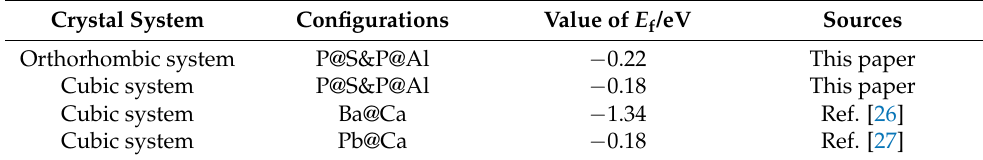
Figure A3. Calculation results of PDOS for pure and the most probably P-doped ye’elimite (position of the Fermi energy level (0 eV) is indicated by a dotted line), ( a ) P@S ＆ P@Al(ST) and ( b ) P@S ＆ P@Al(SS). Table A5. Comparison of E f in this paper and references.